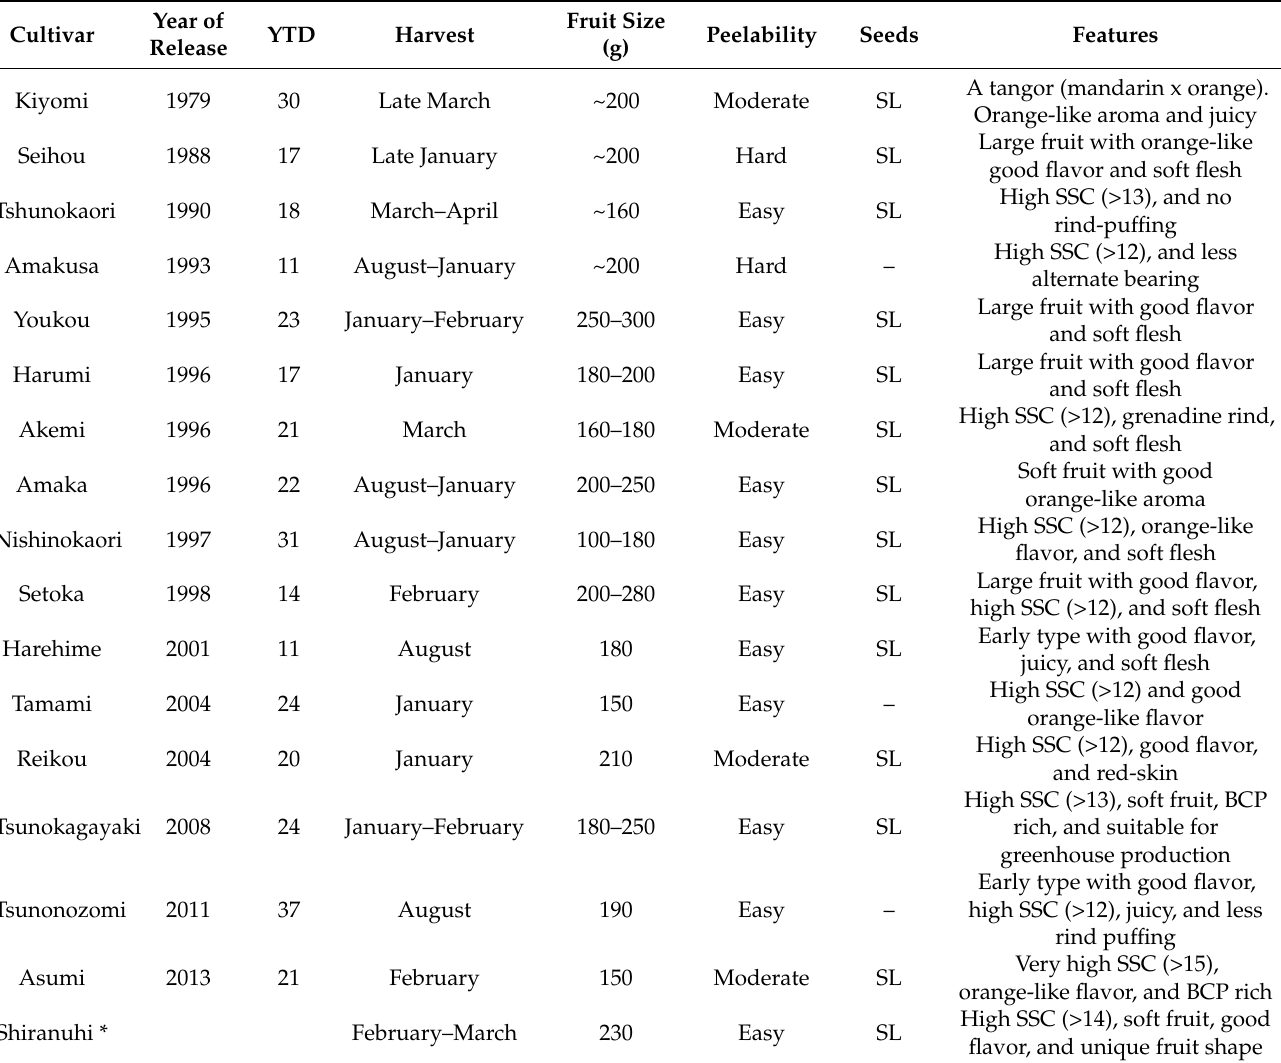
Table 1. List of the offspring cultivars of ‘Kiyomi’. YTD: Years to development, SL: seedless (<5 seeds per fruit), BCP: beta-cryptoxanthin, SSC: soluble solid